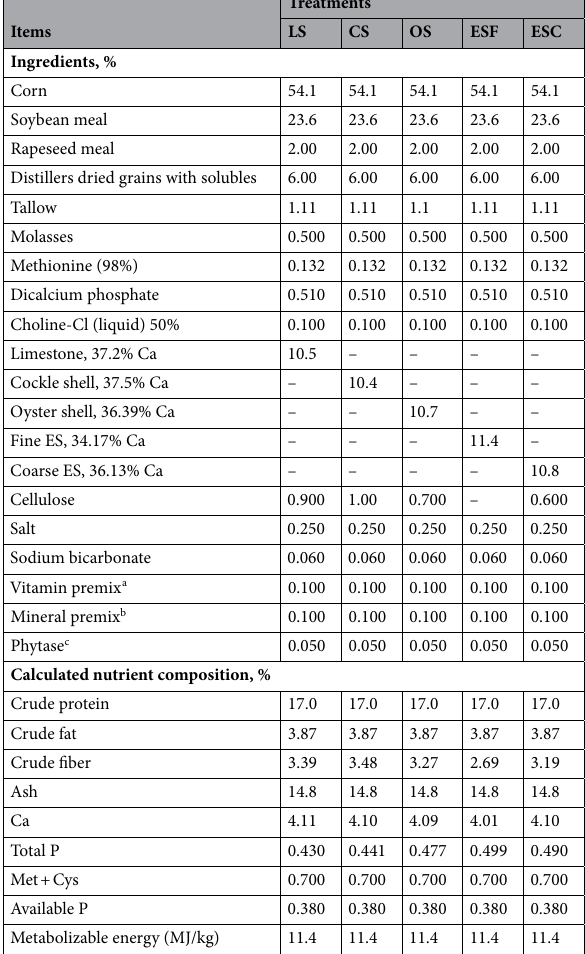
Hen productivity. The number of eggs laid by birds in each replicate was recorded daily once at 10 am and expressed as the percentage of egg production. The hen-day EPR is calculated by dividing the total number of eggs collected by the number of live hens daily in each replicate 55 . The total eggs produced in a day were weighed collectively for every replicate and was used to estimate average egg weight (AEW). Daily egg mass was calculated by multiplying EPR by AEW. Feed intake (FI) was measured weekly once per replicate, weighing the amount of feed distributed and that of residual and scattered feed. The feed conversion ratio (FCR) was calcu- lated based on FI and daily egg mass 56 . The proportion of cracked eggs in each replicate was calculated weekly by dividing the number of cracked eggs by total eggs. Mortality was recorded during the experiment. Egg quality. Forty eggs per treatment (4 eggs per replicate) were randomly selected after each week and analyzed for their quality on the same day of collection. Egg quality traits including egg weight, albumen height, Haugh unit, yolk color, shell strength, and shell thickness were determined using an automatic egg analyzer (Digital egg tester DET6000, NABEL, Co. Ltd., Japan). The Haugh unit is calculated using the following equa- tion: 100 × log (H + 7.57–1.7 × W 0.37 ), where H = albumen height (mm) and W = egg weight (g) 57 . Shell color was determined by using a QCR shell color reflectometer (Technical Services and Supplies, York, UK) as indicated by Safaa et al. 23 . A total of 1400 eggs were analyzed throughout the 7 week of study.